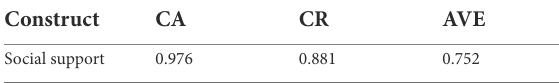
TABLE 4 Reliability and validity of second-order reflective constructs.